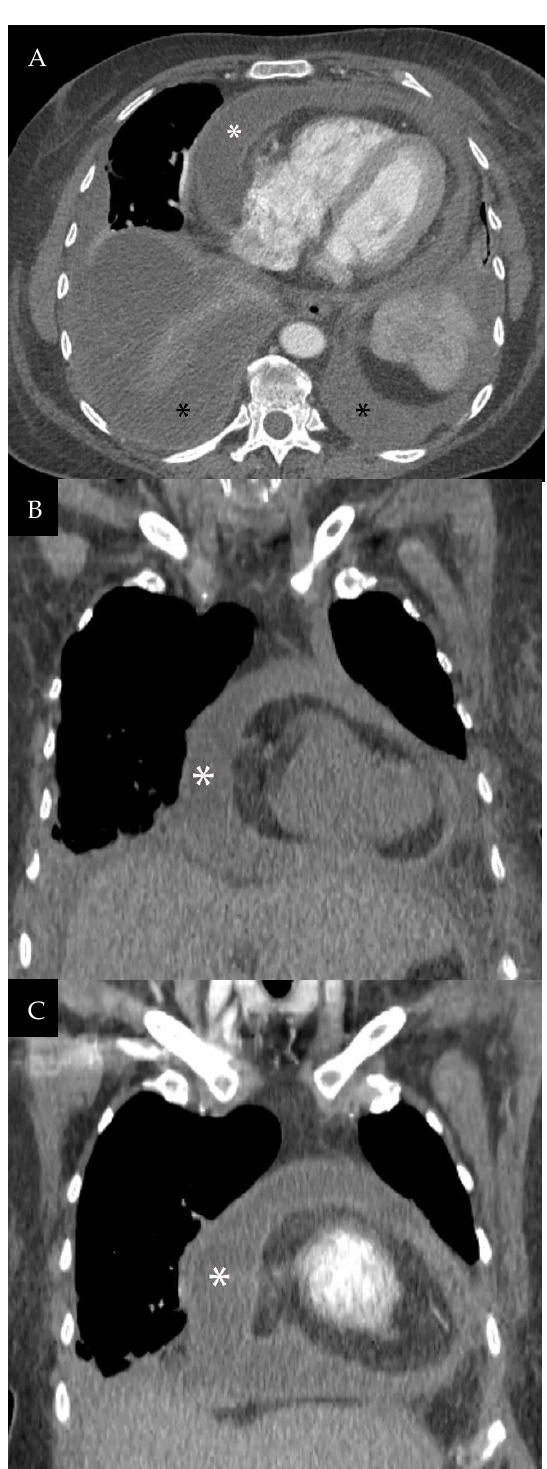
Figure 11. Acute pericarditis mimicking malignant pericardial effusion. 63 year-old woman with multiple myeloma presents with septic shock. ( A ) Axial contrast enhanced CT, ( B , C ) coronal CT pre- and post- intravenous contrast show enhancing pericardial thickening measuring 4 mm in thickness and a moderate pericardial effusion (white asterisk). Note bilateral pleural effusions (black asterisks) and nodular right posterior pleural thickening. Analysis of the pericardial and right pleural effusions showed tuberculosis. Infectious inflammatory processes such as pericarditis and empyema can mimic metastatic disease. Reprinted from Shroff, G.S et al. Pitfalls in oncologic imaging of the pericardium on CT and PET/CT [4].